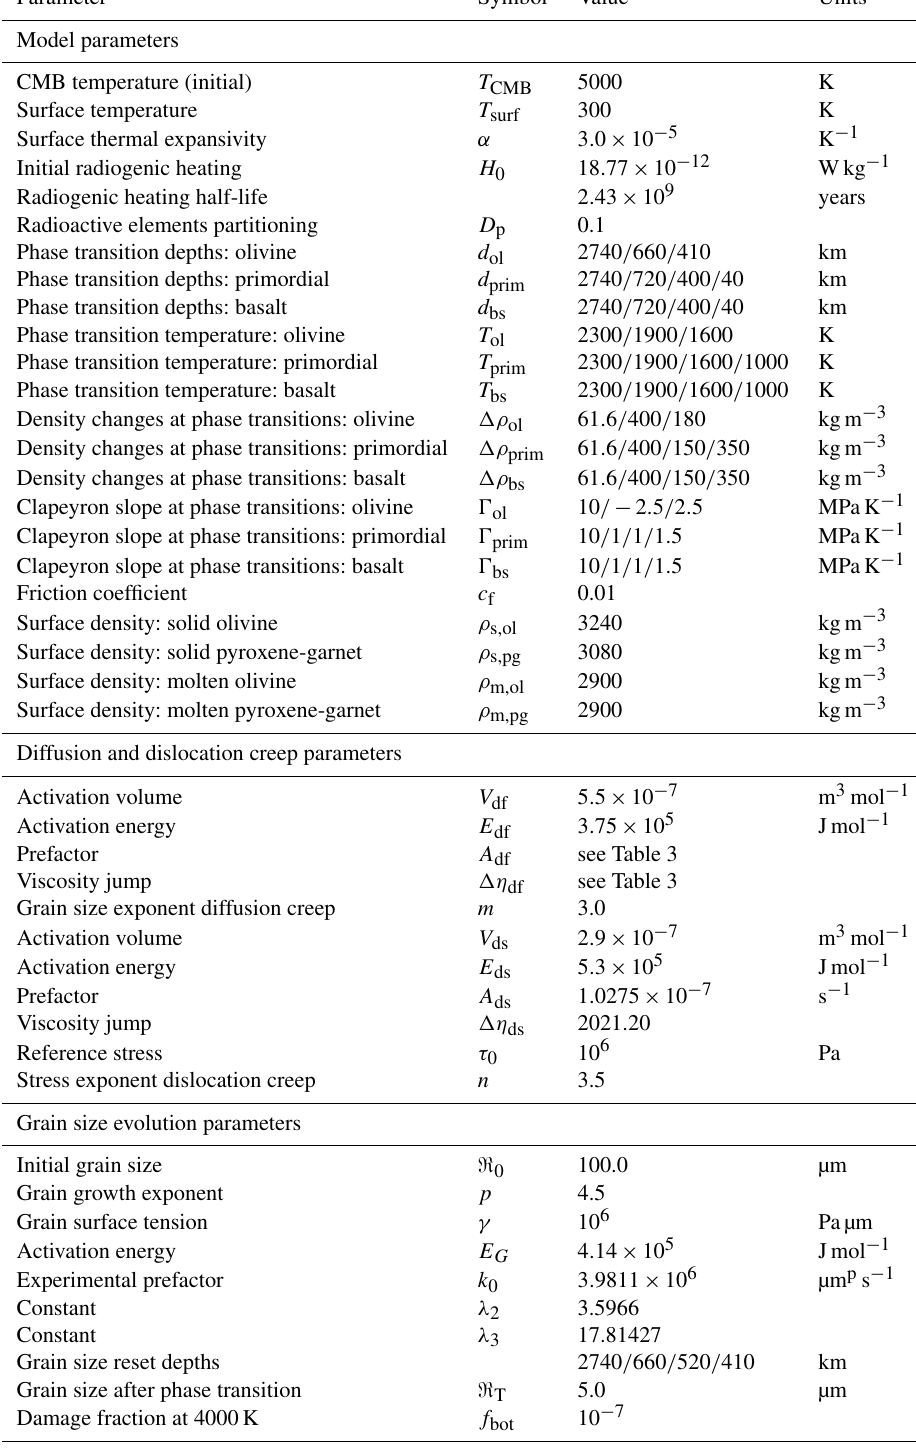
Table 1. List of grain-size-related and general model set-up parameters. Grain size parameters are taken from Yamazaki et al. (2005). Parameter Symbol Value Units Model